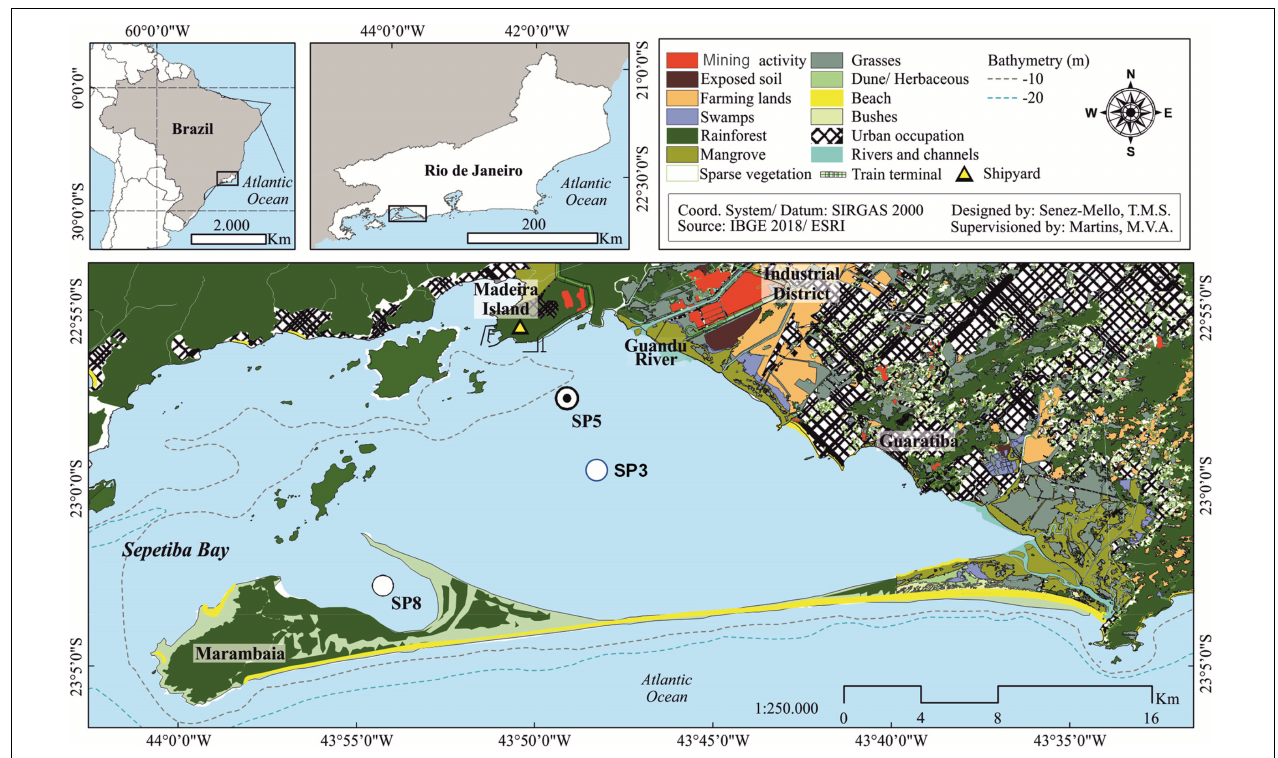
FIGURE 1 | Study area and location of core SP5, as well as core SP8 used for the calculation of Ecological Quality Ratio, and core